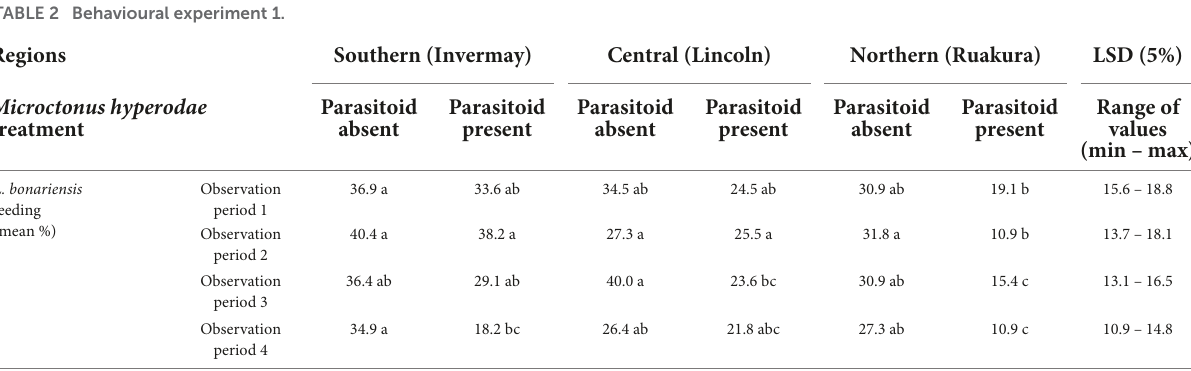
TABLE 2 Behavioural experiment